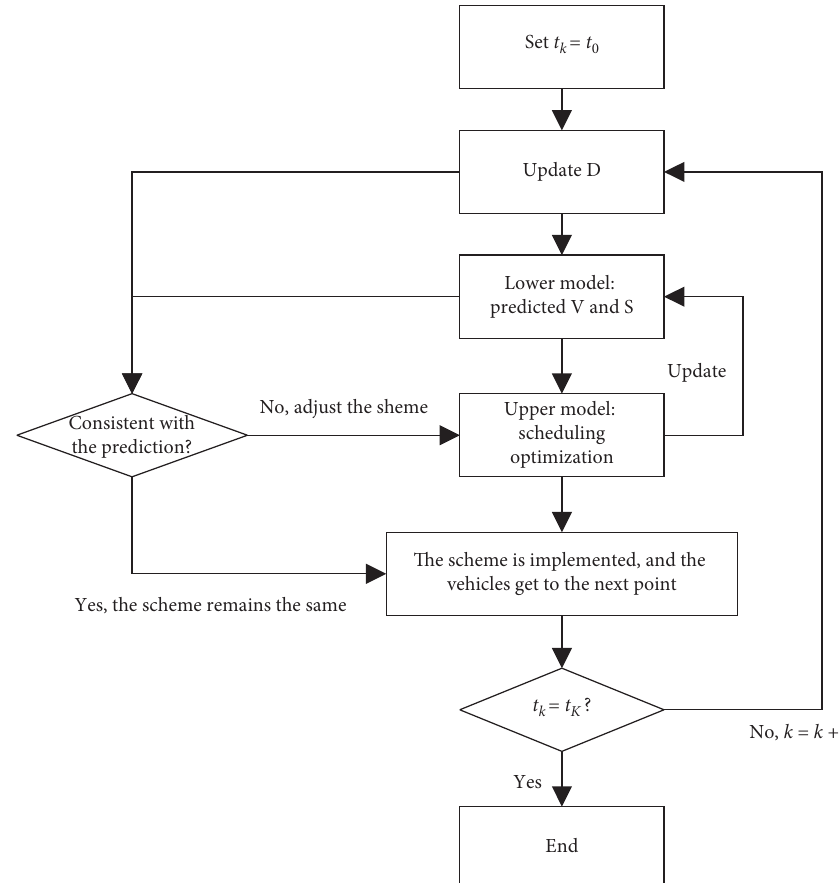
Figure 2: Simulation flow chart of bike-sharing dynamic scheduling